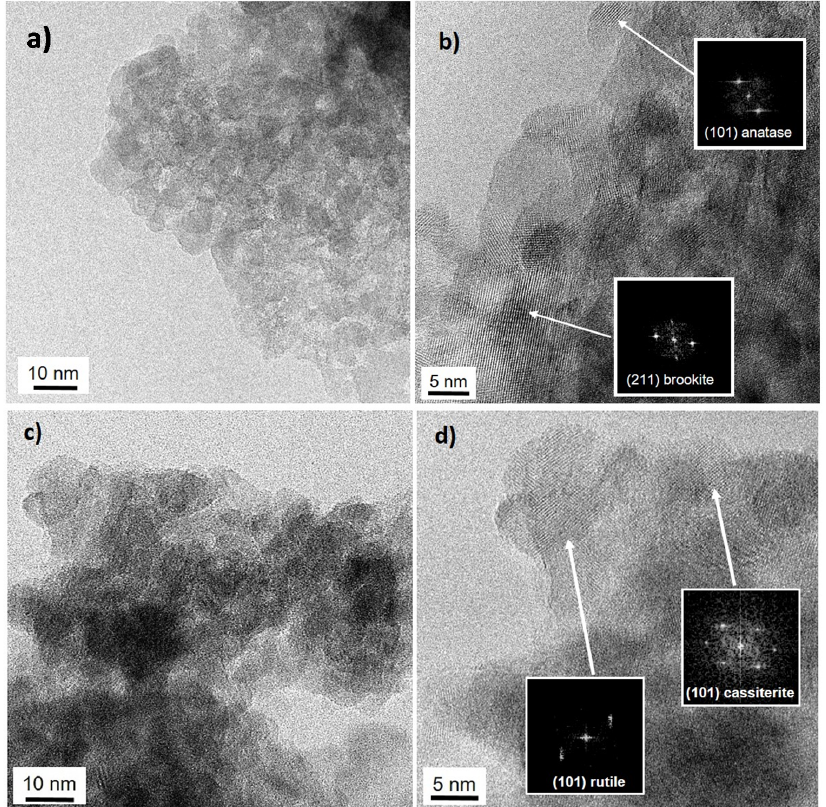
Figure 2. TEM images of ( a , b ) TiSn5_C and ( c , d ) TiSn20_C. Scale bars are 10 nm ( a , c ) and 5 nm ( b , d ). Insets: electron diffraction patterns of the detected polymorphs.